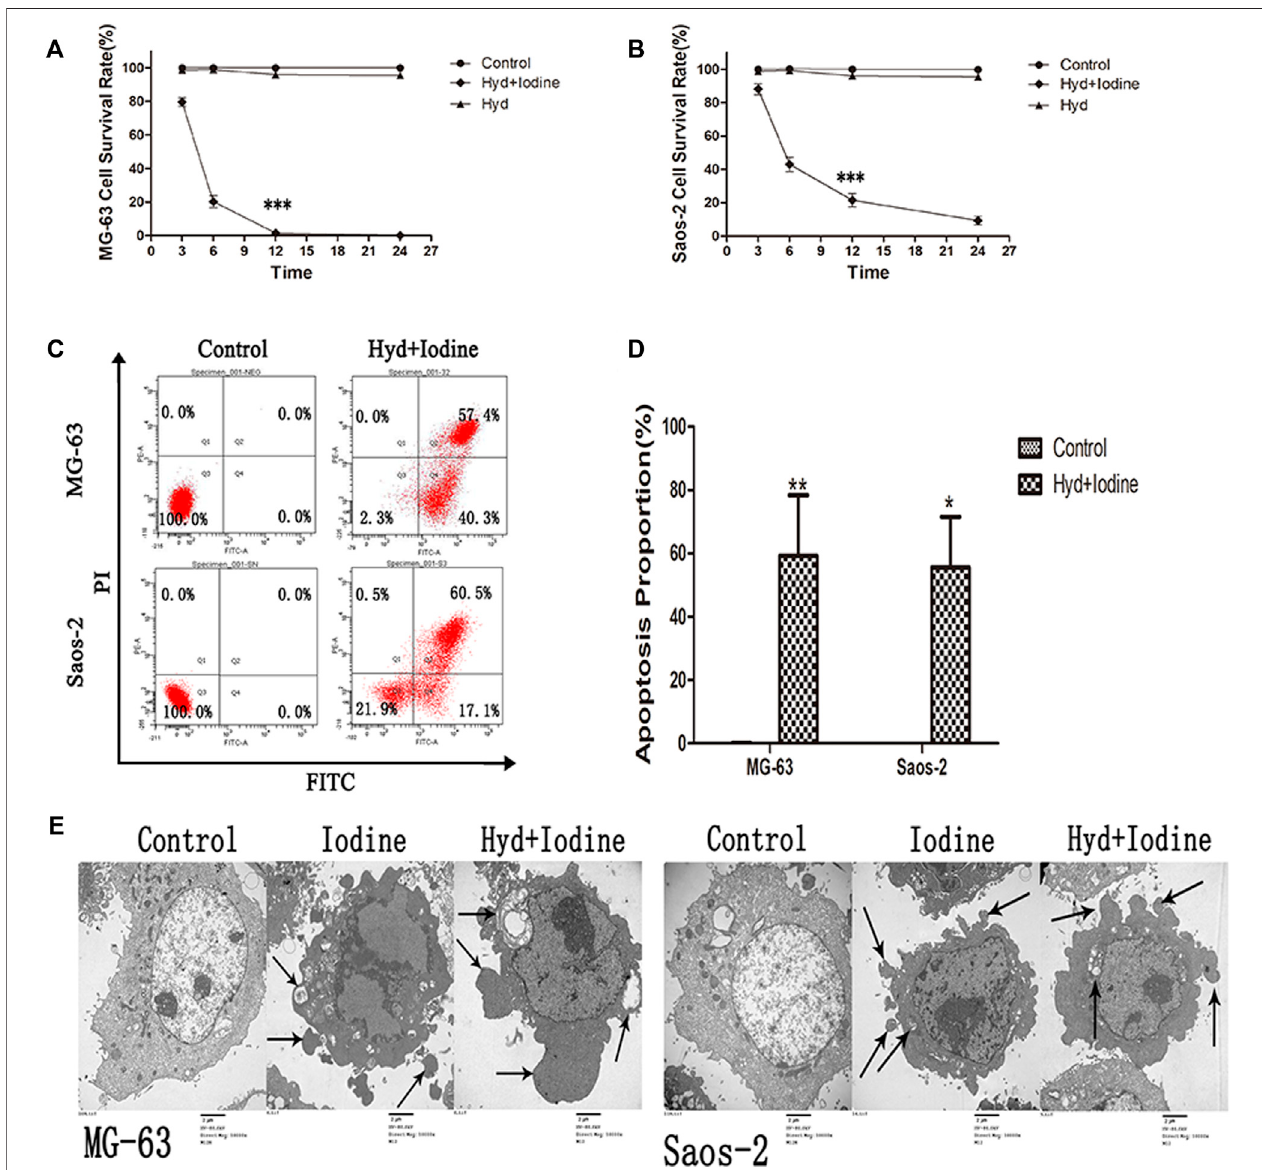
FIGURE 4 | Iodine released by the self-assembling imageable silk hydrogel induced apoptosis in OS cells. (A,B) After 3, 6, 12 and 24 h of treatment with released iodinesolution,thecellsurvivalratewasassessedbyaCCK-8assay(*** p < 0.001). (C) After12 hoftreatmentwithreleasediodinesolution,theproportionsofcells(MG- 63 and Saos-2) undergoing apoptosis were analysed by fl ow cytometry after staining with Annexin V-FITC/PI. (D) The proportion of apoptotic OS cells after treatment with released iodine solution (* p < 0.05, ** p < 0.01). The mean percentages of cells undergoing apoptosis (±SD) are shown. (E) The apoptotic ultrastructure of OS cellstreatedwithiodineandreleasediodinesolution.Thearrowsindicateapoptoticbodies.Thecellswereexaminedunderatransmissionelectronmicroscope.Control: untreated OS cells, Iodine: treated with PVP-I, Hyd + Iodine: treated with iodine solution released by hydrogel (Magni fi cation, 10000X; Scale bar = 2 µm) (OS, osteosarcoma; CCK-8, Cell Counting Kit-8; Annexin V-FITC/PI, Annexin V-FITC/PI Apoptosis Detection Kit; SD, standard deviation; PVP-I, polyvinylpyrrolidone iodine).